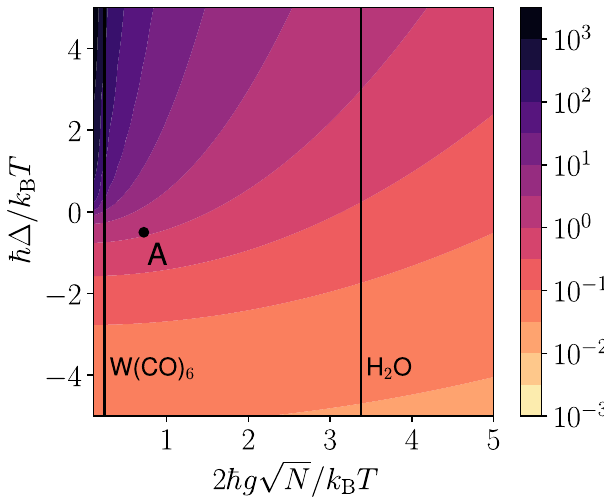
The average population per molecule at the condensation = N Γ threshold (cid:2) n ¼ P # is a good measure of the feasibility of th vibrational polariton condensation. For instance, demanding population inversion, (cid:2) n > 0 : 5, would be experimentally dif fi cult to achieve in general. In Fig. 3, we plot (cid:2) n for different light-matter ffiffiffiffi p coupling strengths, 2 _ g N , and detunings, ℏ Δ . Here, we numerically obtain P th as the pumping rate when 10% of the excitations are in the lower polariton. The threshold obtained this way closely corresponds with the theoretical condition for condensation